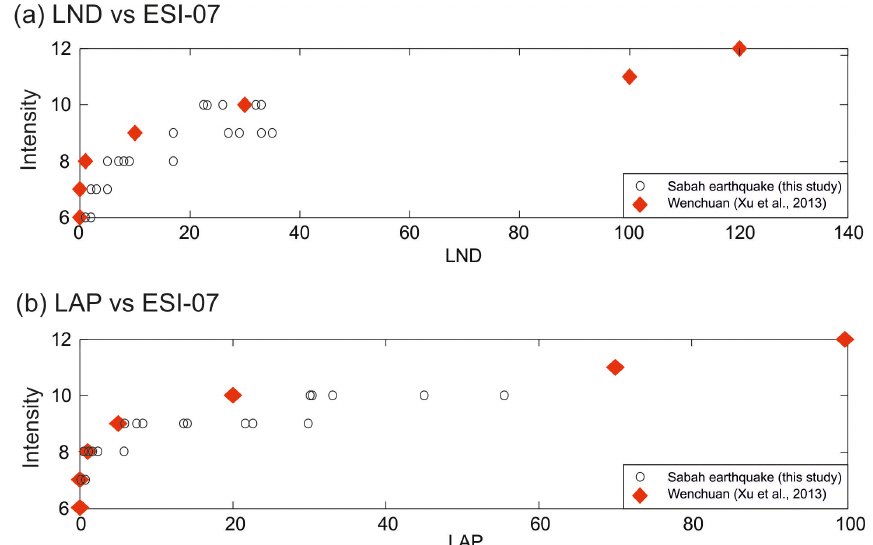
Figure 9. Plots of LND (a) and LAP (b) vs. ESI-07 values; small black circles are the median values for the Sabah earthquake, obtained with the different scaling laws. Red diamonds are the values proposed by Xu et al. (2013) for the 2008 Wenchuan earthquake. This study adopts the ESI-07 scale, while the classes by Xu et al. (2013) refer to the Chinese intensity